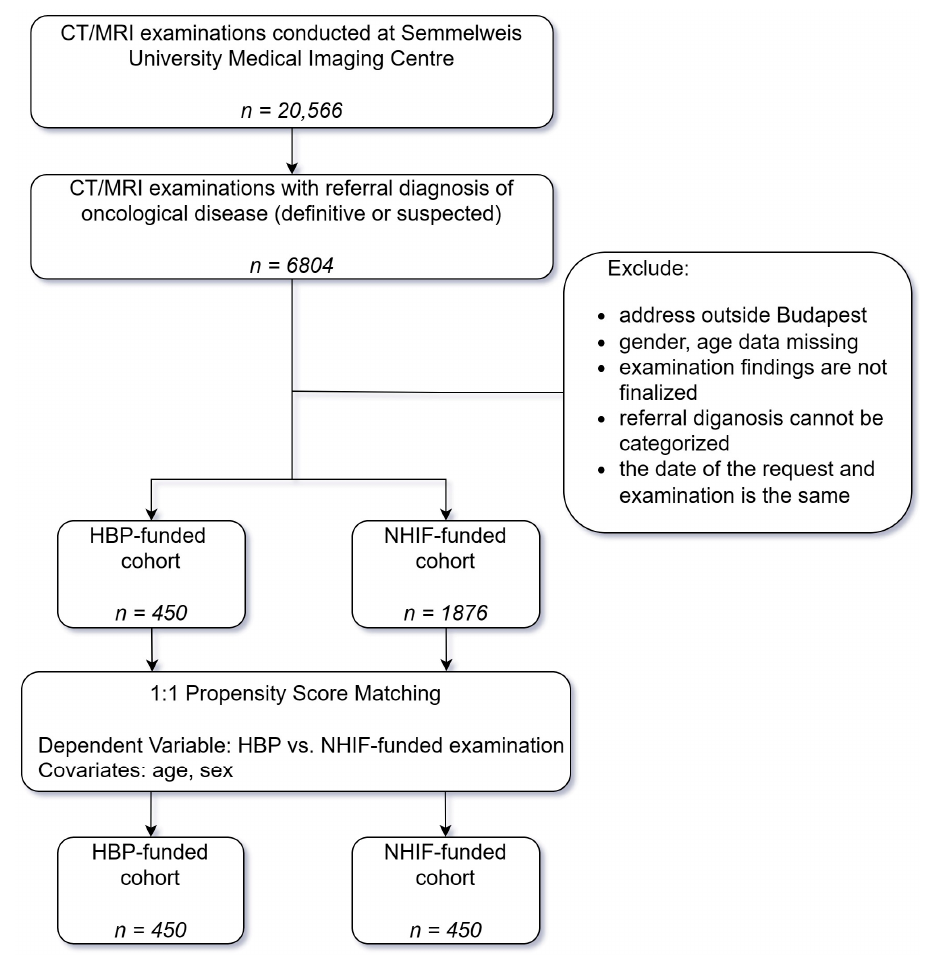
Figure 1. Flowchart of the investigation. HBP: Healthy Budapest Program, NHIF: National Health Insurance Fund.